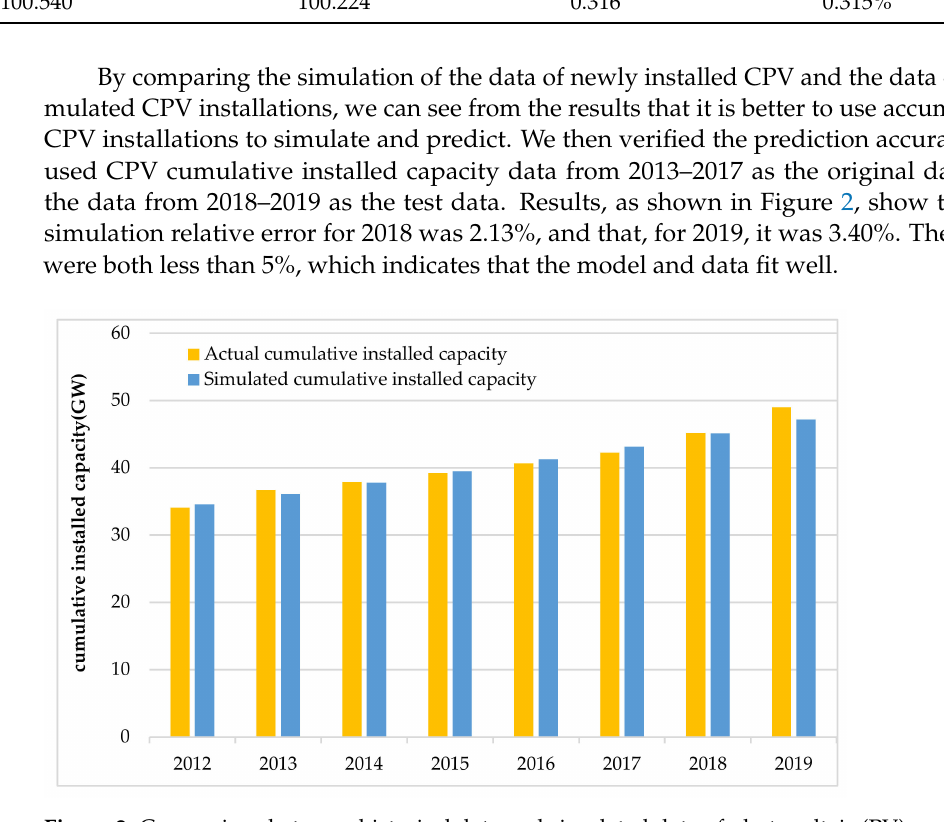
Figure 2. Comparison between historical data and simulated data of photovoltaic (PV) cumulative installed capacity in